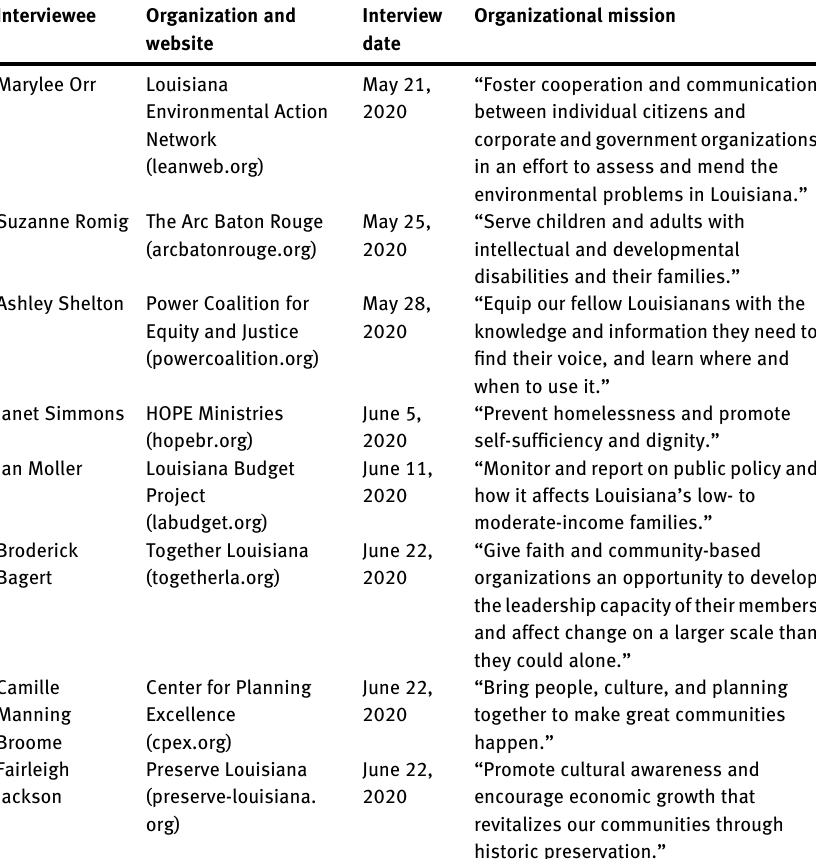
Table  : Nonpro fi t leaders